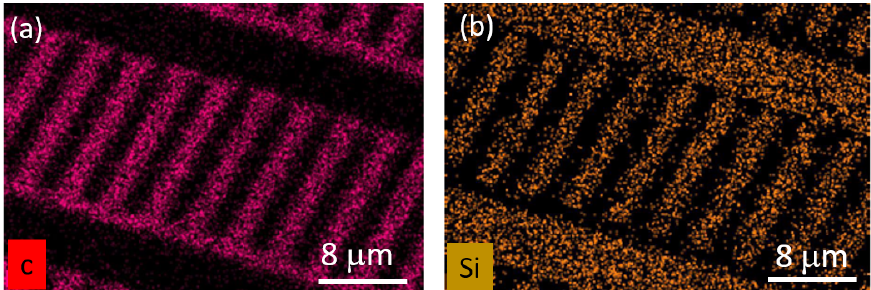
Figure 4. Energy dispersive X-ray (EDX) spectroscopy mapping of SCD cantilevers prepared by the presented method. The EDX mapping has been performed after the SF 6 plasma, the O 2 plasma etching the SCD structures (parameters see Table 1) and the wet chemical removal of residual HSQ: ( a ) carbon signal; and ( b ) silicon signal. The two maps show complementary images, clearly indicating that,